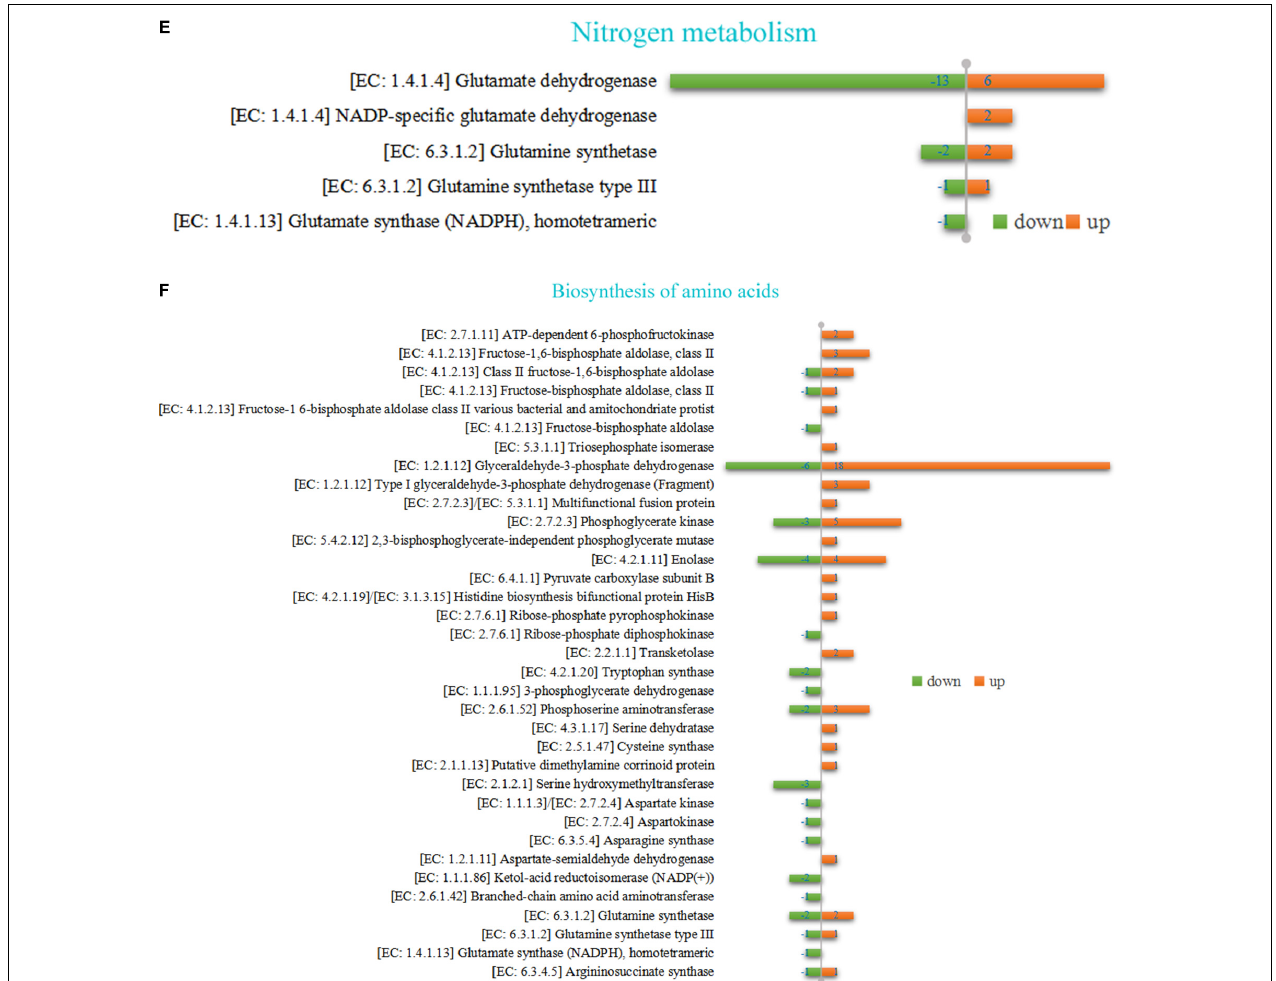
FIGURE 7 | Protein identity and regulation involved in several important pathway in rumen fluid samples of beef cattle fed with a CrPyr supplementation diet (experimental group vs. control group, EG vs. CG). (A) Fatty acid metabolism. (B) Pyruvate metabolism. (C) Glycolysis/gluconeogenesis. (D) Citrate cycle (TCA cycle). (E) Nitrogen metabolism. (F) Biosynthesis of amino